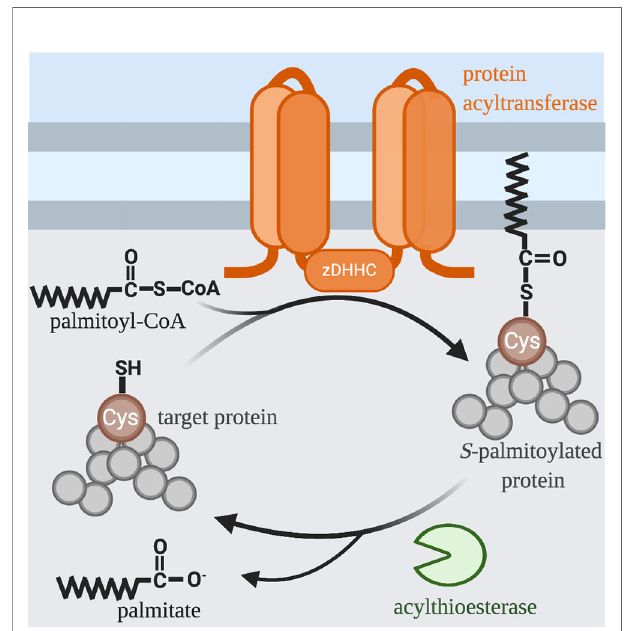
FIGURE 1 | S -acylation Cycle. The palmitoyl group is transferred to the free thiol of cysteine from palmitoyl-CoA by a family of integral membrane zinc- dependent DHHC protein acyltransferases. The hydrophobicity of palmitate allows modi fi ed proteins to associate with the membranes of various organelles and facilitates traf fi cking between these organelles. Acyl-protein thioesterases remove thioester-linked fatty acids and thus regenerate a free thiol